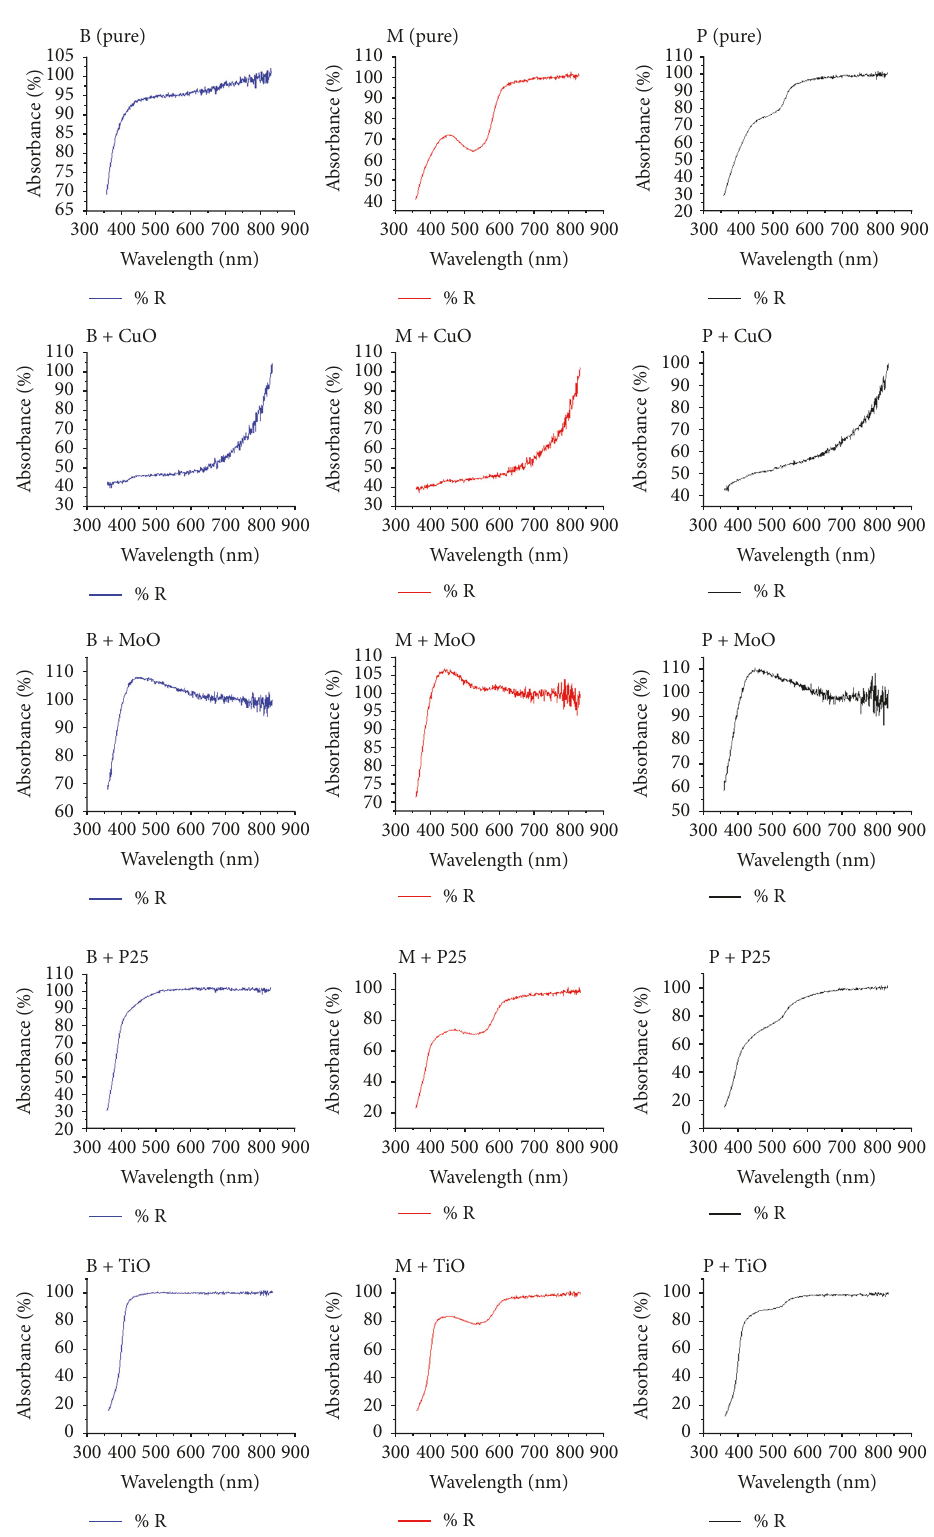
Figure 4: UV-Vis absorption spectra of samples in pure state and also doped with metal oxides